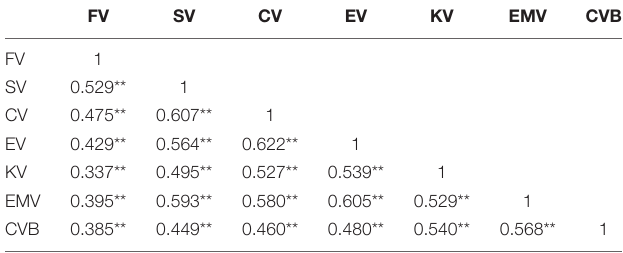
TABLE 5 | Descriptive statistics of variables in the study conducted in Pakistan. Constructs/variables